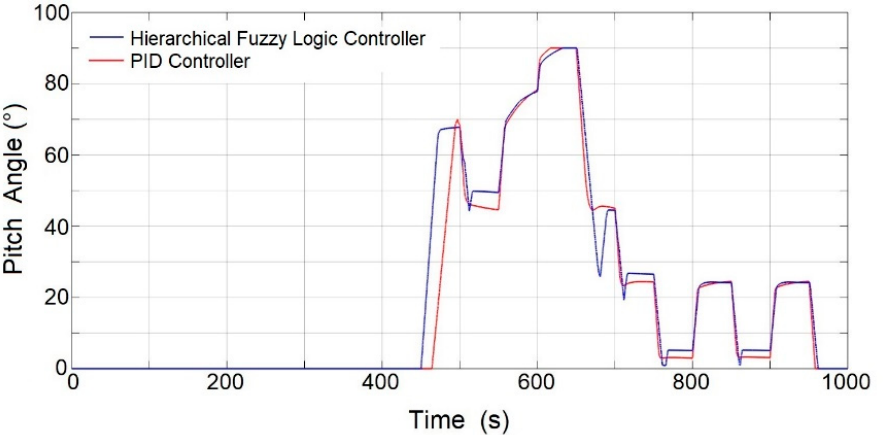
Figure 18. Pitch angle movement. There is also a difference in the pitch angle paths, where the HFLC makes sudden (peak-shaped) changes in the angle path, while the PID controller makes smooth changes. To carry out the experiment, only real winds in the predominant direction between 70 are considered, which represents 72% of the annual time. When the wind direction is in another direction range, the controller switches to a conventional PID controller. The development of the algorithm in real operating conditions is shown in Figure 19.